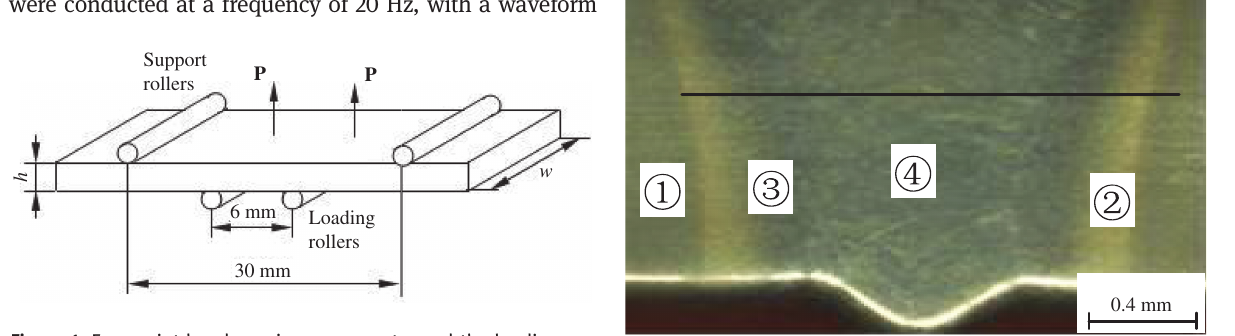
Figure 1: Four-point bend specimens geometry and the loading states. Figure 2: Macro-photograph of welded